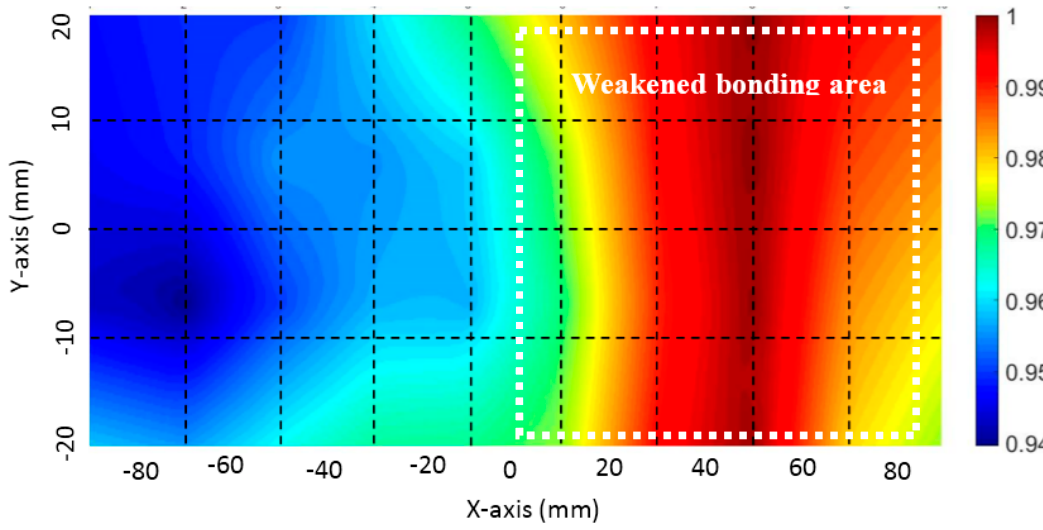
Figure 15. Imaging result of the adhesive bonded triplex layer using continuous wavelet transform (CWT). The white rectangular box shows the actual location of the weakened bonding provided by Hyundai Heavy Industries ® .